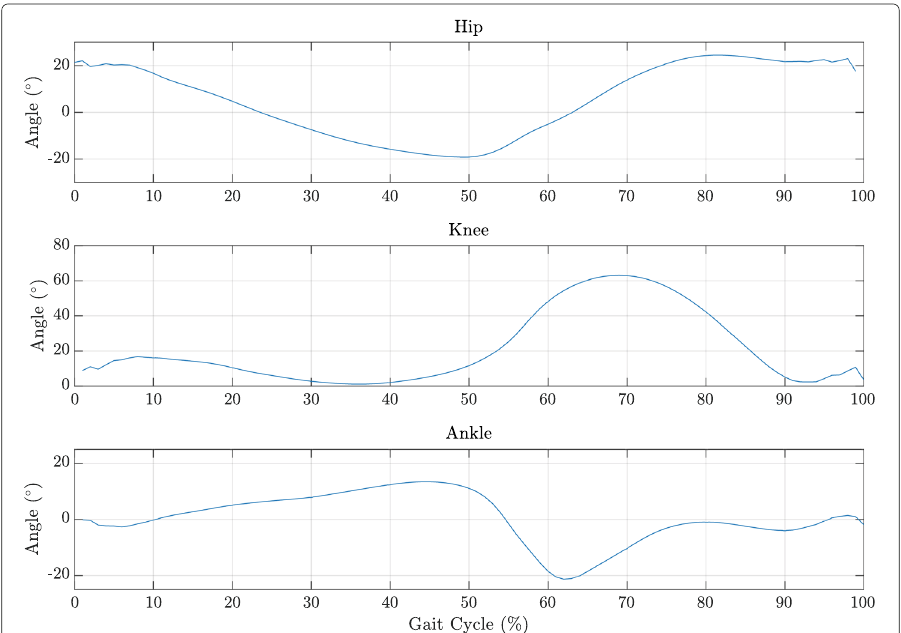
Fig. 2 Reference lower body joint angles in the sagittal plane during one gait cycle using the kinematic gait data from the IMUs